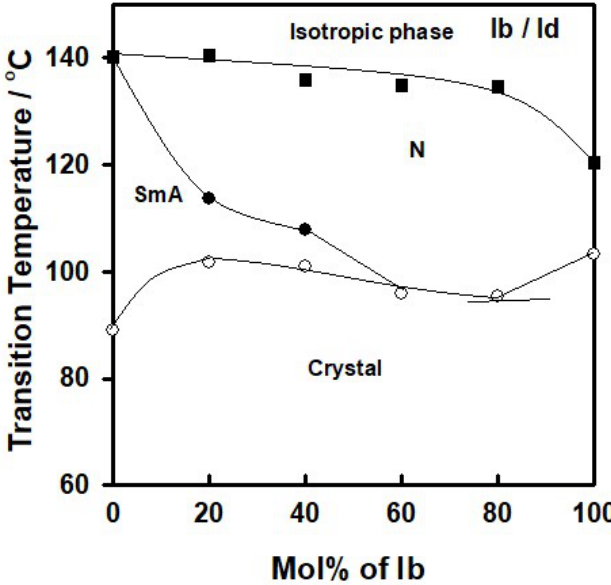
Figure 4. Binary phase diagrams for system Ib / Id; the symbol “o” denotes the solid–SmA phase, “ • ” the SmA–N phase transitions, “ ■ ” the N–I phase transition upon second heating, and “------” denotes the eutectic mixture.